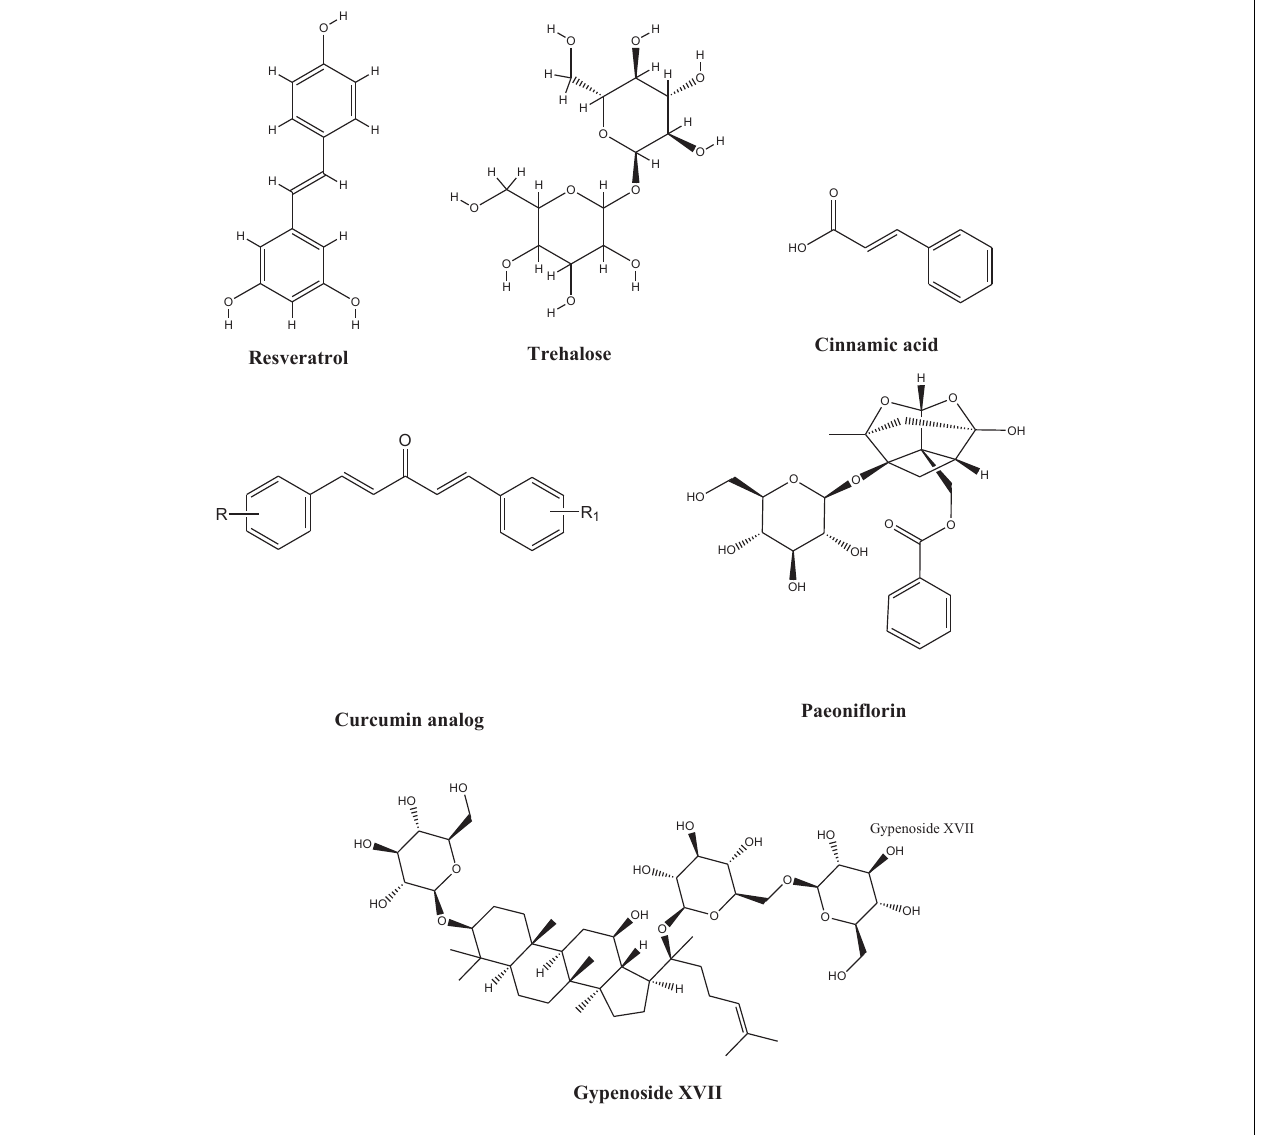
FIGURE 3 | Chemical structures of natural compounds with therapeutic potential against neuro